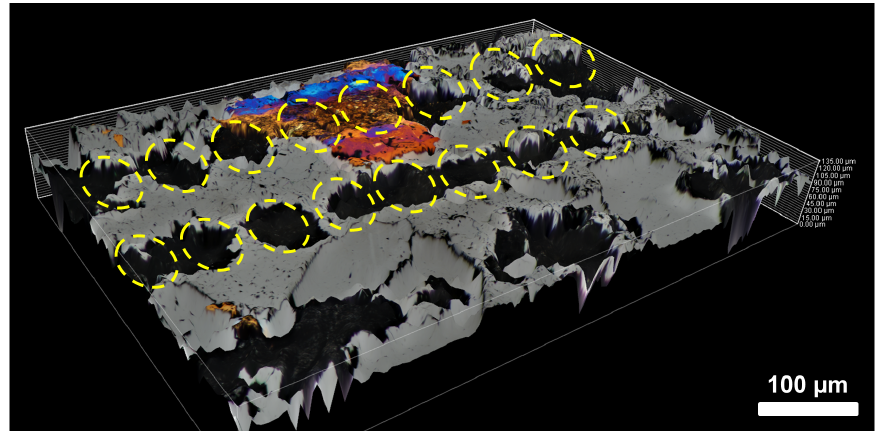
Figure 24. Reflected light 3D step image of LIBS craters (outlined in yellow circles) in quartz (gray) and chalcopyrite (colored). While the ablation depth in quartz is more than 50 µ m, the ablation depth in Cu-sulfide minerals is 1–5 µ